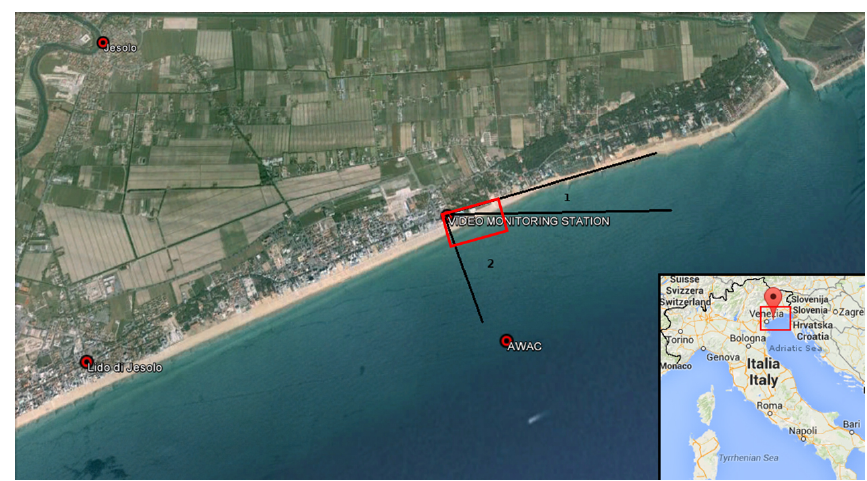
Figure 1. Satellite image of the site. The location of the AWAC and of the video-monitoring station are reported with red bullets, the angles of view of the two cameras are plotted in black, and the analysed section of beach is highlighted by the red